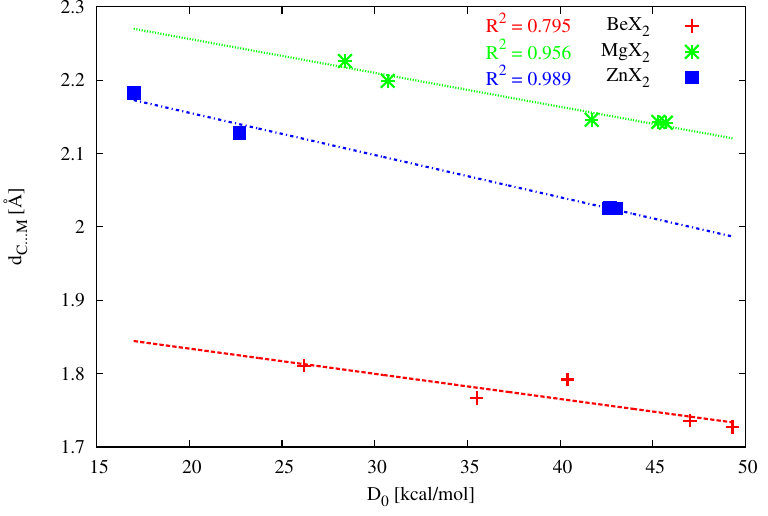
Figure 12. Relationships between d C ··· M and D 0 obtained for (PH 3 ) 2 C · · · MX 2 (X = Be, Mg, Zn)